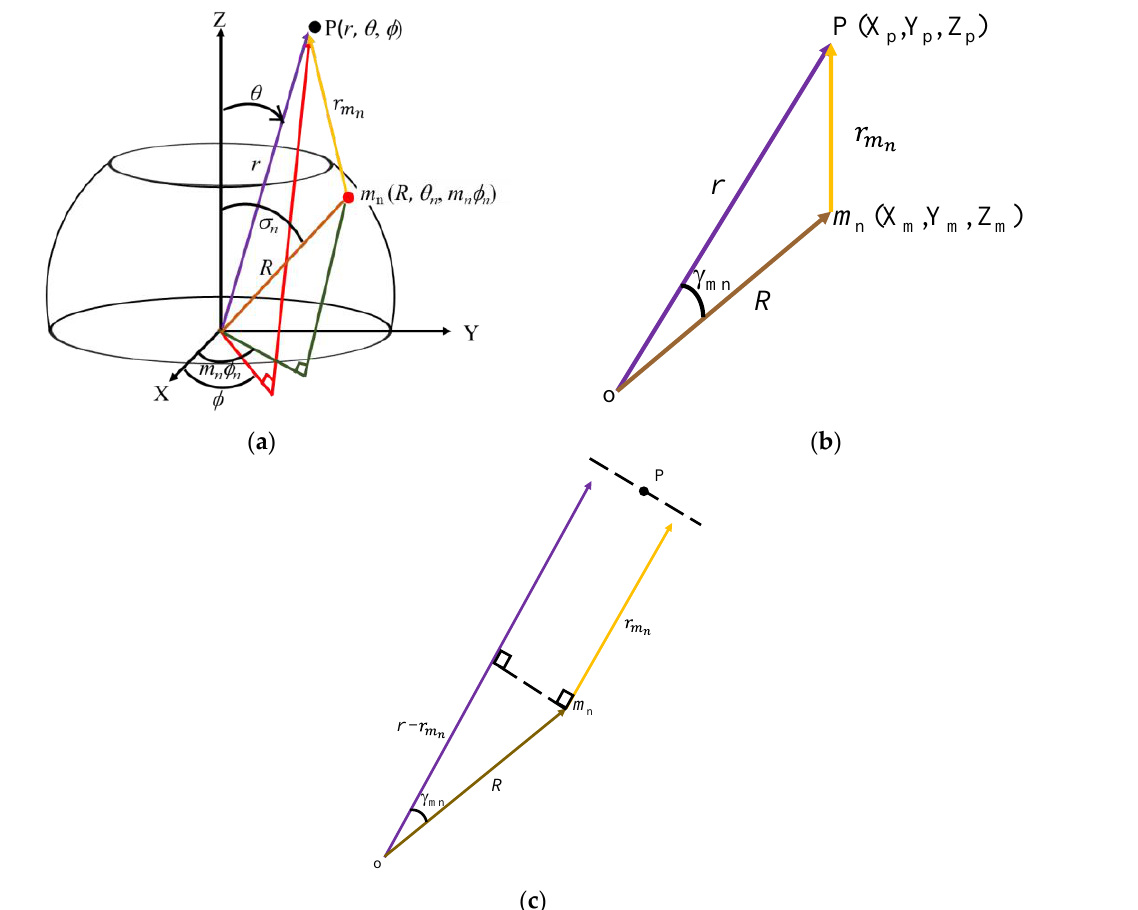
Figure 5. Diagrammatical illustrations for the derivation of the directional factor of an acoustical point source on the spherical segment platform: ( a ) spherical coordinate; ( b ) rectangular coordinate; and ( c ) propagation line parallelism at a far−field distance.